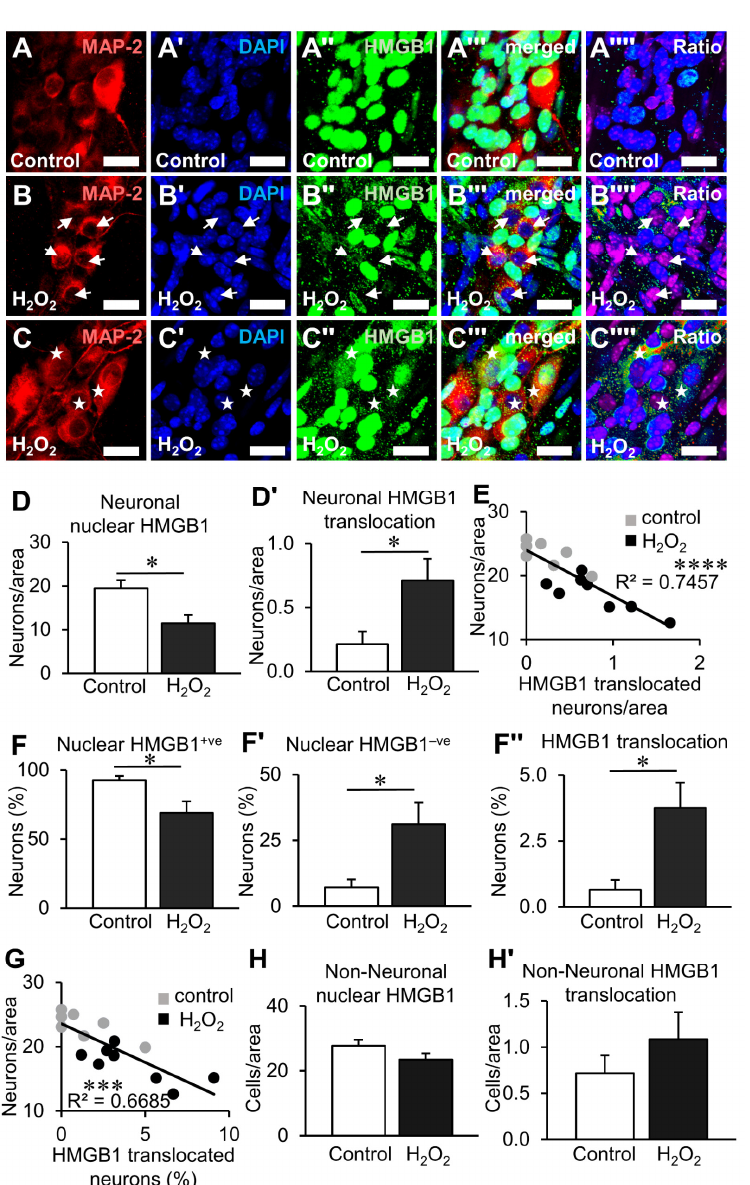
Figure 5. Effects of hydrogen peroxide on HMGB1 expression in myenteric neurons after organotypic culture. ( A – C”” ) HMGB1 expression within the myenteric ganglia in distal colon organotypic cultures. Myenteric neurons observed by immunofluorescence of the neuronal marker MAP-2 ( A – C ), nuclear stain with DAPI ( A’ – C’ ), HMGB1 ( A” – C” ), merged images ( A”’ – C”’ ) and ratio representations of HMGB1:DAPI ( A”” – C”” ) for visual distinction. Tissues were cultured for 24 h in standard culture medium ( A ) or medium with 100 µ M H 2 O 2 ( B , C ). Neurons without nuclear HMGB1 expression are denoted by arrows ( B – B”” ) and neurons with HMGB1 translocation into the cytoplasm are denoted by stars ( C – C”” ) (scale bar = 20 µ m). ( D , D’ ) Quantification of neurons with HMGB1 expressed in the nucleus ( D ) and translocated to the cytoplasm ( D’ ) presented as neurons per ganglionated area. ( E ) Linear correlation between neuronal density and neurons with translocation of HMGB1 per area. ( F – F” ) Percentage of neurons with HMGB1 expressed in the nucleus ( F ), absent in the nucleus ( F’